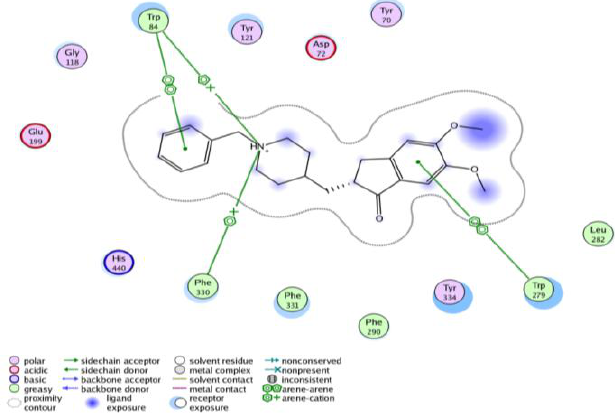
Figure 3. Interactions of donepezil with the amino acids of the active site of AChE.